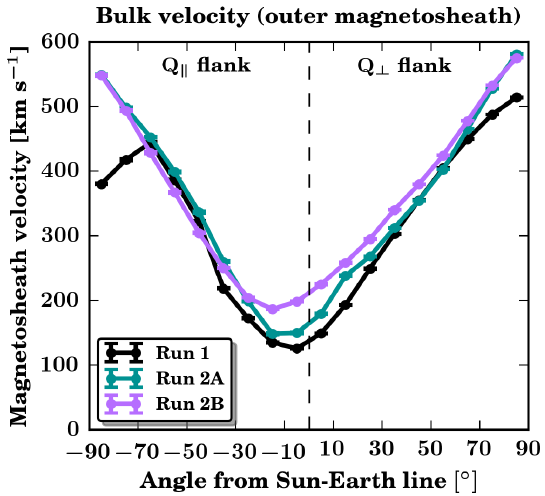
Figure 4. Bulk velocity in the outer magnetosheath as a function of the angle from the Sun–Earth line in all three runs.